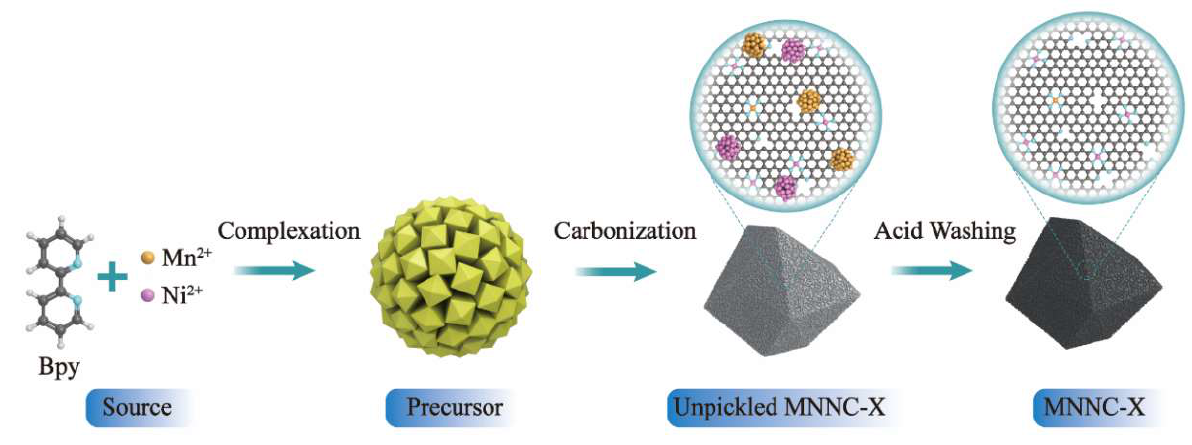
Figure 1. Schematic diagram for the synthesis of MNNC.